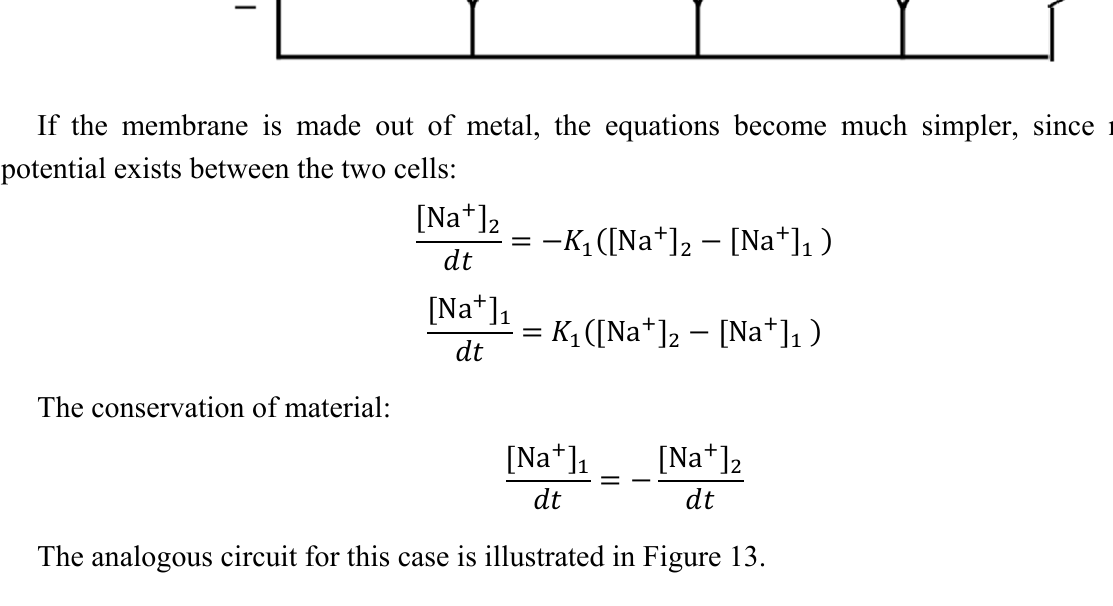
and [Na + ] that are 1 2